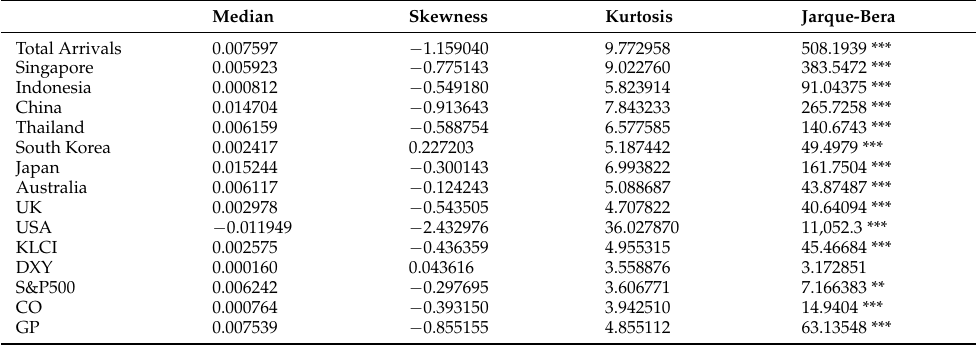
Table 6. Summary of statistics for ε t